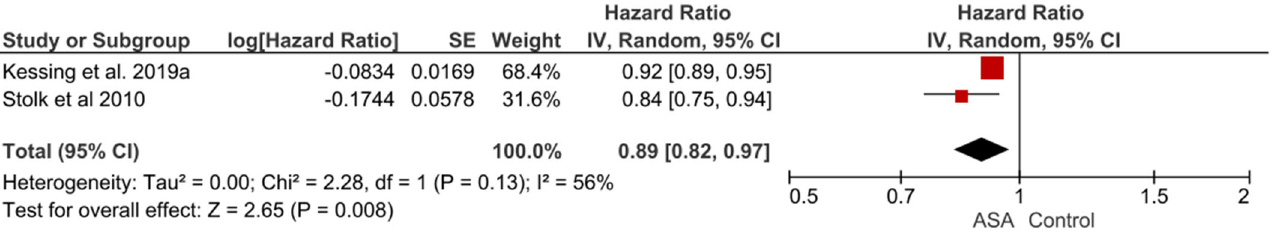
Figure 7. Observational studies on the effect of ASA on bipolar disorder symptoms–the pooled hazard ratio.